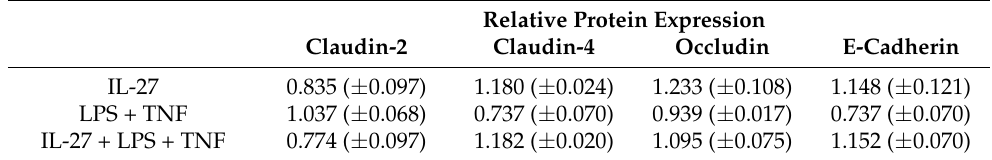
Table 1. Epithelial junctional protein expression data in human colonic organoids in an inflammatory